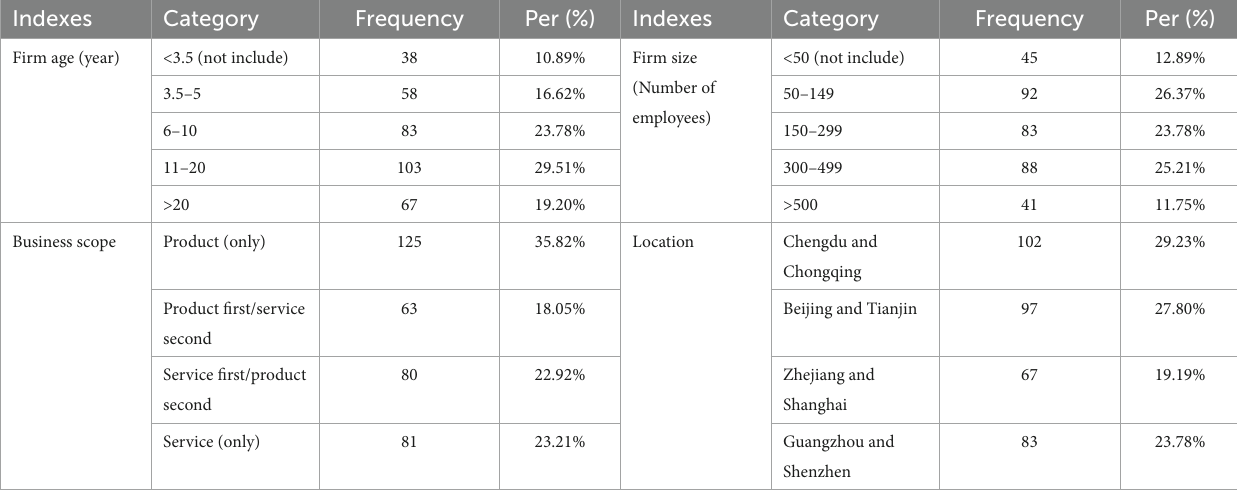
TABLE 1 Descriptive statistics of